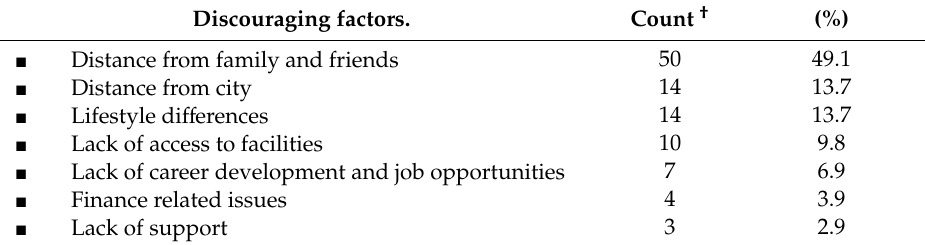
Table 5. Summary of open-ended question on discouraging factors to practise in rural area. Discouraging